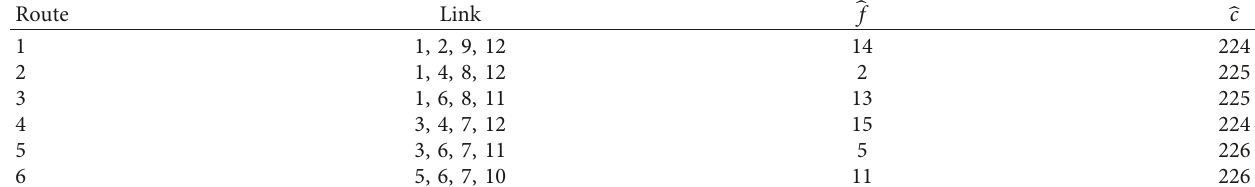
Table 7: Route flow and perceived cost in mixed equilibrium for travellers in the third group. Route